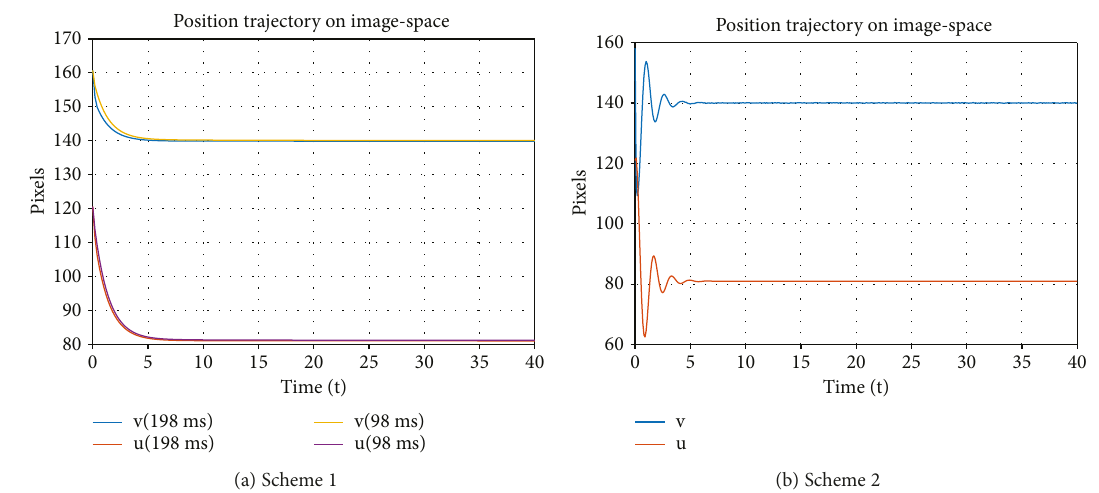
Figure 5: Position trajectory of the feature point on the image plane.